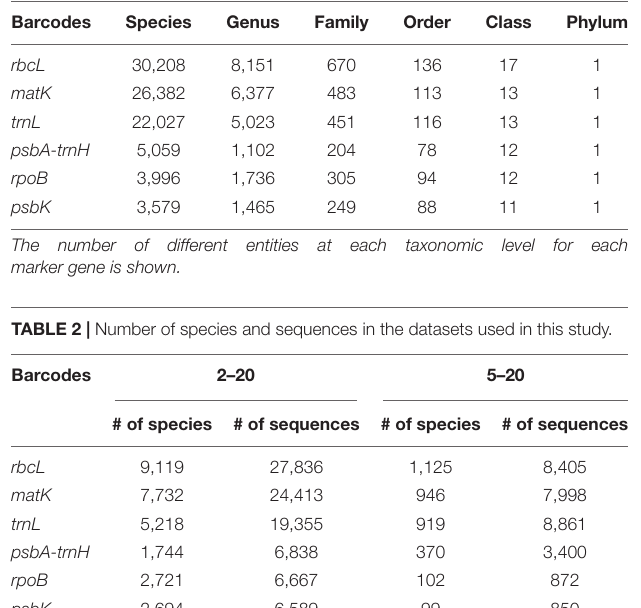
TABLE 1 | Taxonomical representation of selected markers at different taxonomical levels.